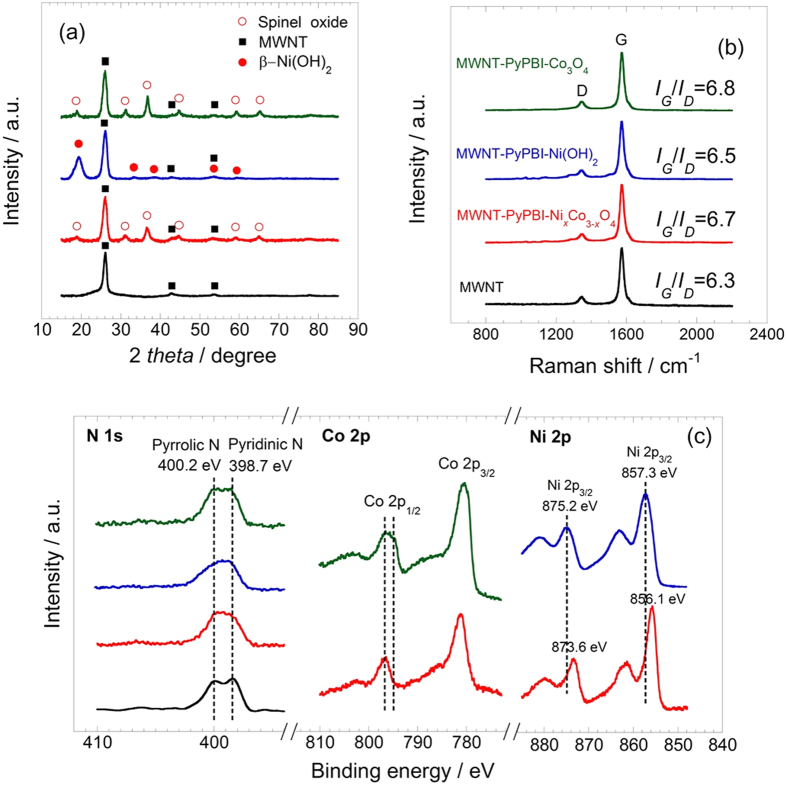
Structure identification of the three products.(a) XRD patterns, (b) Raman spectra, and (c) XPS profiles of MWNT-PyPBI-NixCo3−xO4 (red), MWNT-PyPBI-Co3O4 (green), MWNT-PyPBI-Ni(OH)2 (blue), and MWNT (black).